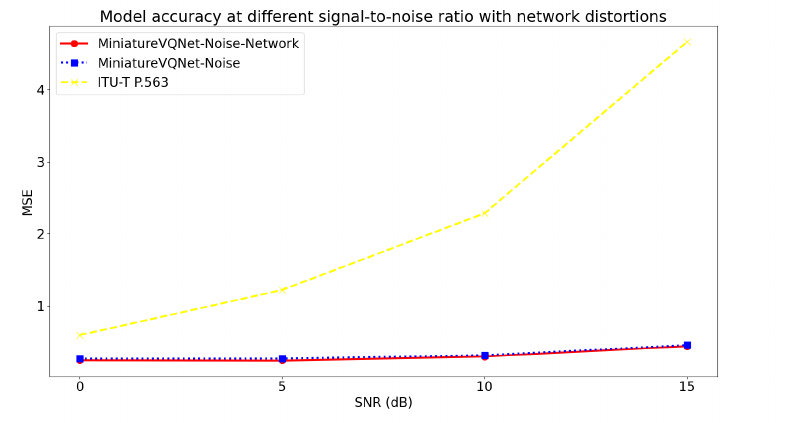
Figure 2. MSE for different models.